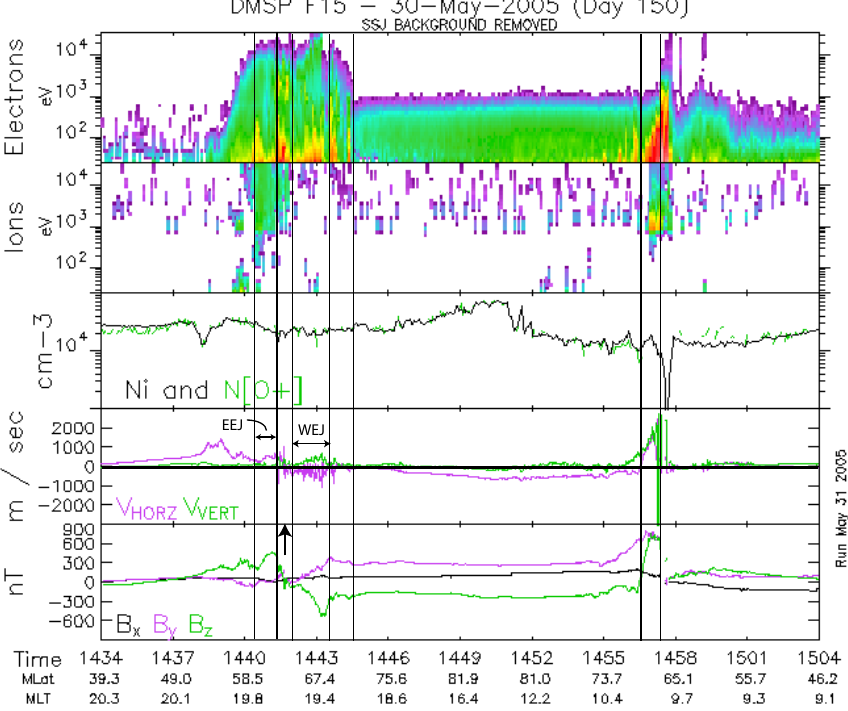
Fig. 6. DMSP F15 data obtained during the pass from pre-midnight to pre-noon in the interval 14:34–15:04UT. Panels from top to bottom show electron and ion energy spectrograms, ion density, cross-track ion drift (horizontal component in violet), and magnetic deflection components B x , B y , and B z ( B z is the east-west component shown in green). Ion isotropy boundary, pre-breakup arc (PBA), polar cap boundary and flow channel at 67–69 ◦ MLAT/10MLT are marked by vertical guidelines. Latitude regimes of auroral electrojets (EEJ and WEJ) are